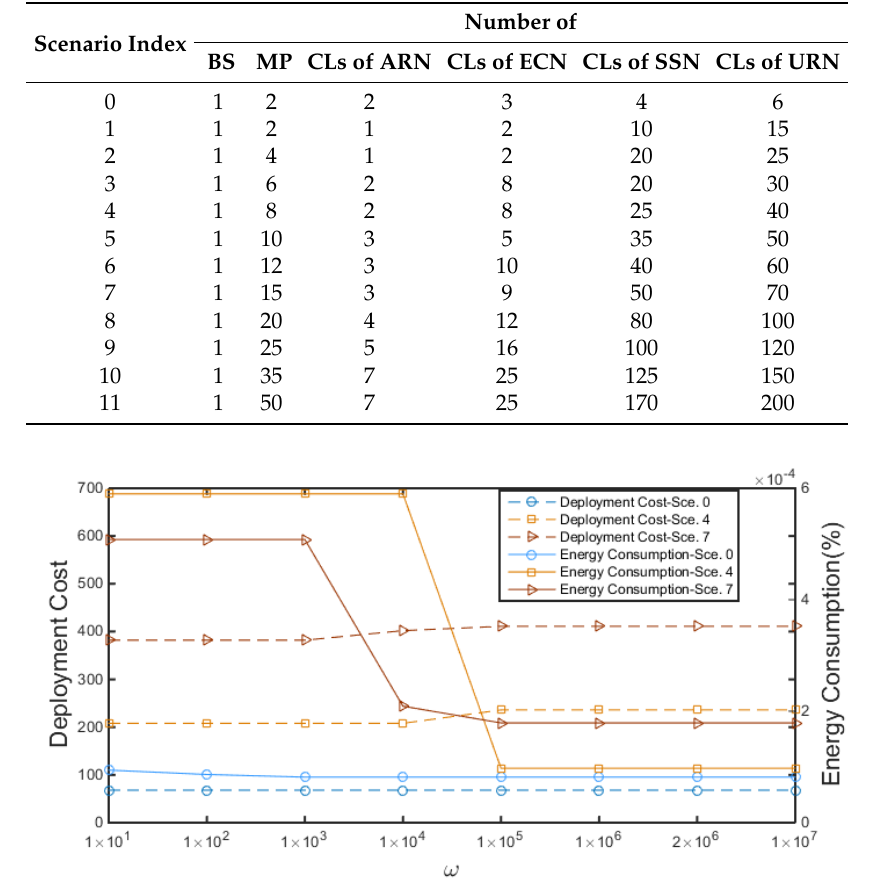
Figure 3. The impacts of ω : DC stands for Deployment Cost, and EC stands for Energy Consumption. Sce. is the abbreviation of Scenario. Table 3. Parameter